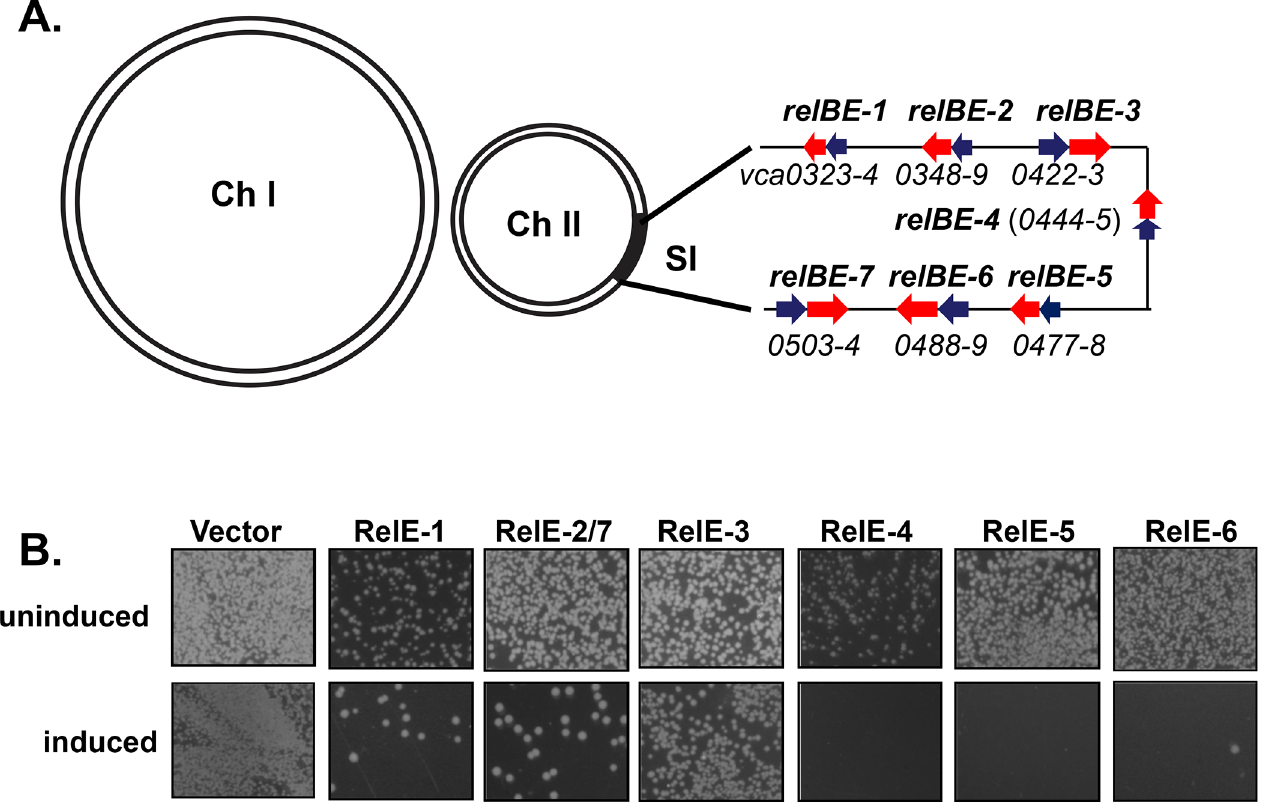
Fig 1. V . cholerae RelBE TA systems and their function. A. Location of RelBE-family in Vibrio cholerae chromosome II superintegron (SI). RelE toxins are labeled with red and RelB antitoxin blue. Genes are depicted in correct orientation with relative size, and in the absence of intervening non-TA genes. B. RelE toxin activity. Each of six relE genes was cloned into pBAD33. Purified construction plasmids were electroporated into BW27784 cells. After one hour recovery, same volume of culture was plated on LB agar with 0.2% glucose (uninduced) or 0.2% Arabinose (induced). Photographs were taken after 16h incubation at 37°C. pBAD33 vector was used as a